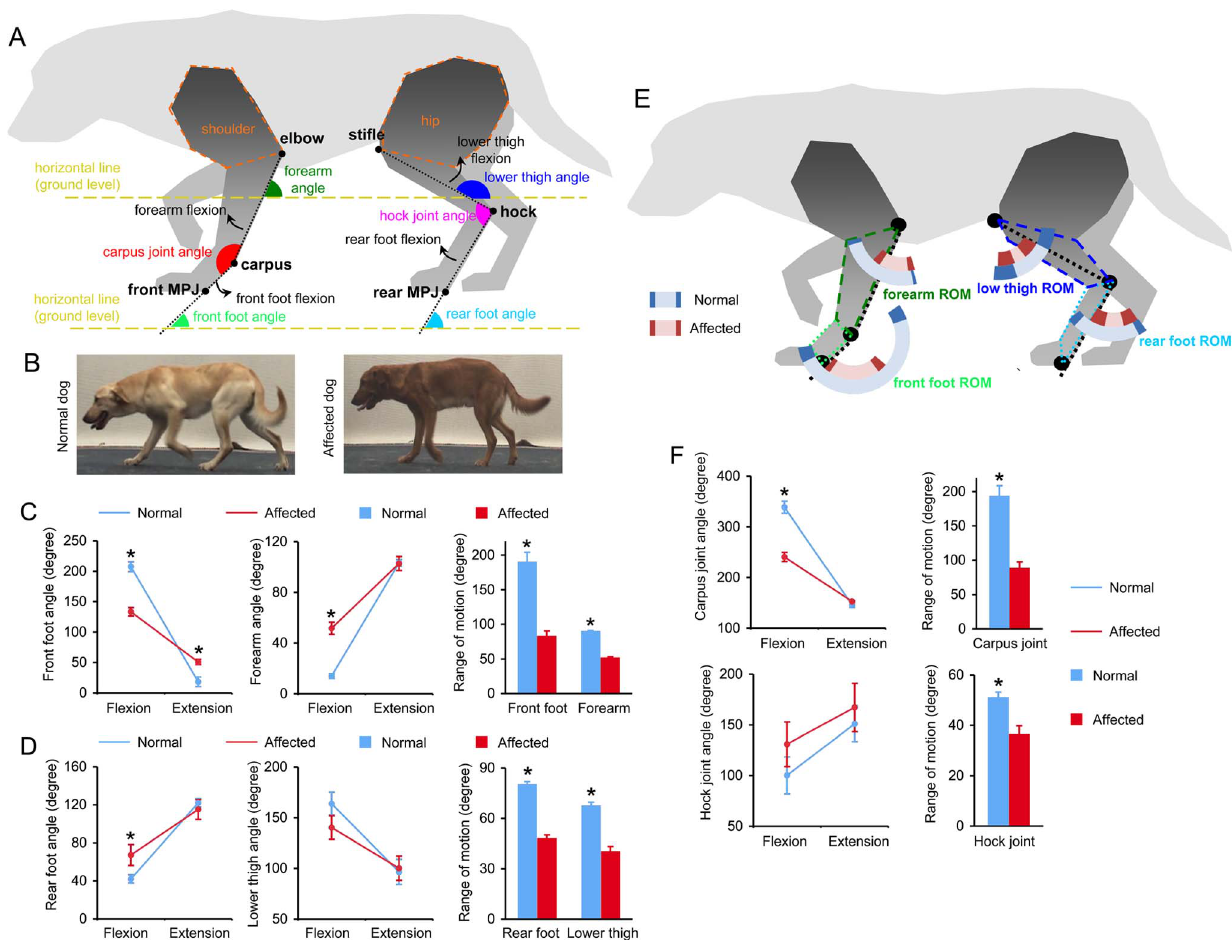
Figure 2. Angle measurements revealed significant reductions in the range of motion of the limb segments and joints in dystrophic dogs. A, Cartoon illustration of the reference points (elbow, carpus, front MPJ, stifle, hock and rear MPJ), limb angles (forearm angle, front foot angle, lower thigh angle and rear foot angle) and joint angles (carpus joint angle and hock joint angle). Also shown is the direction of limb segment flexion. The directions of carpus and hock joint flexions are the same as that of front foot and rear foot flexions, respectively. The shoulders and hips were not studied. B, Representative pictures converted from side-view video recording. Left panel, a normal dog; Right panel, an affected dog. The affected showed a stiff and straightened posture. C, The angles and the range of motions in the front foot and forearm. D, The angles and the range of motions in the rear foot and lower thigh. E, Doughnut drawing of the range of motion in each limb segment. Normal dogs, outer doughnut; Affected dogs, inner doughnut. Dark shaded region stands for the standard error of mean. The outline of each limb segment is color-coded to be consistent with the color of legend labels. F, The angles and the range of motion in the carpus and hock joints. Asterisk, significant difference between normal and affected dogs. Representative side-view video clips from normal and affected dogs are shown in movies S3 and S4,